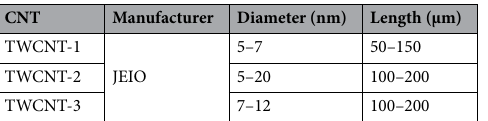
Table 1. Specifications of CNTs used for fabrication of